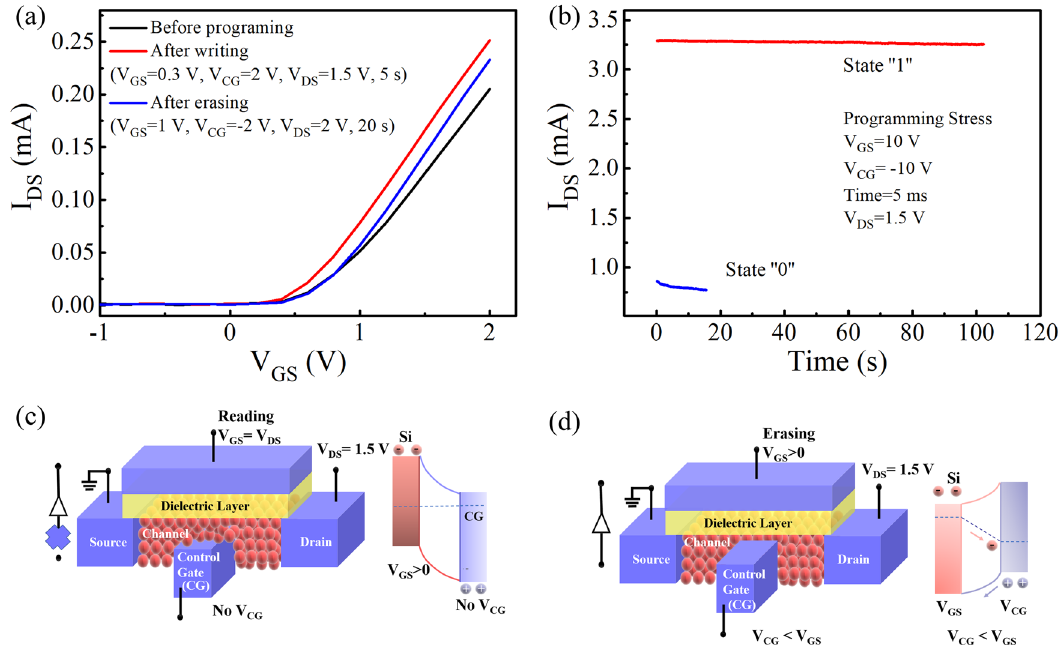
Fig. 4 Memory performance and mechanism diagrams of the one-transistor design. a Transfer characteristics of the device before and after programming. b Retention data of the memory states. The programming time is 5 ms, which is limited by the measurement setup and can be further reduced. c The operation mechanism diagram of the one-transistor design for the reading process. d The operation mechanism diagram of the one- transistor design for programming